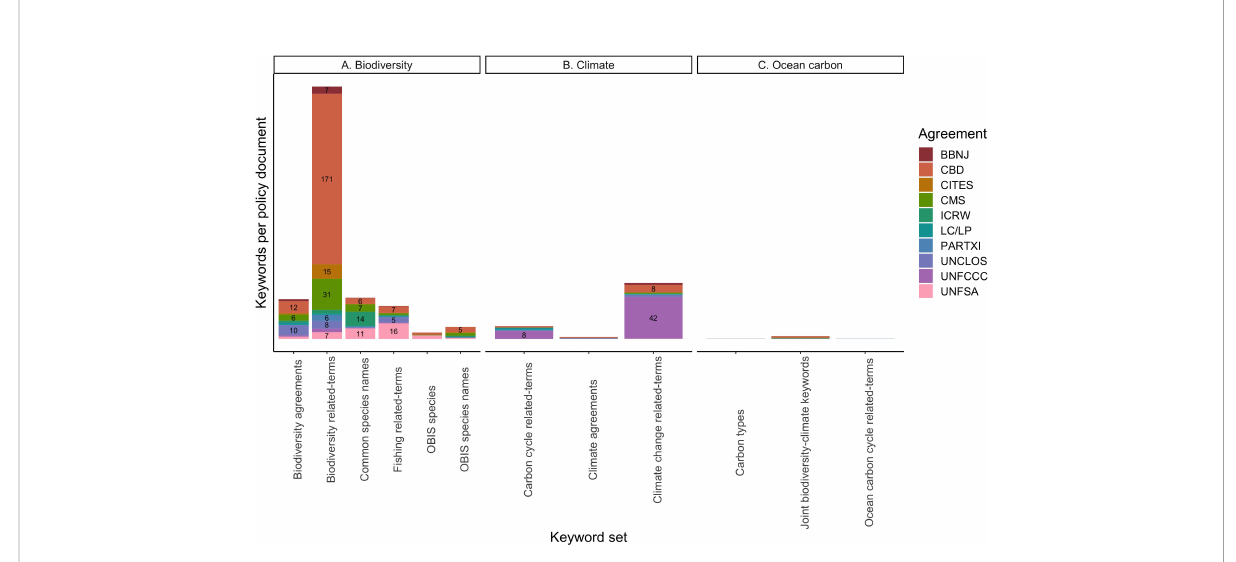
FIGURE 1 Number of keywords per policy document mentioned in different agreements. Keywords were summarized and displayed in keyword sets (e.g., ‘ Common species names ’ and ‘ Fishing related-terms ’ ) and per category (A) Biodiversity, (B) Climate, and (C) Ocean carbon. Table S3 lists all keywords contained in each set and category. Values are rounded and displayed if ≥ 10. OBIS refers to the Ocean Biodiversity Information